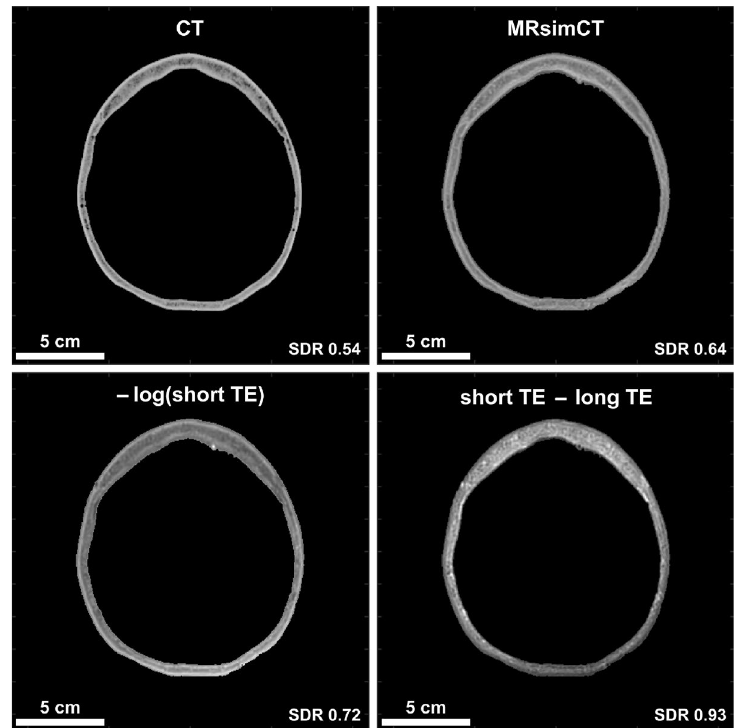
Figure 1. CT contrast of the skull compared to various MR contrasts (skull A). Cortical and trabecular bone contrast is clearly depicted by CT and may be preserved by two of the three MR post-processing methods. The units for MRsimCT, –log(short TE), and short TE–long TE are not the same, thus different windowing and leveling were used. Scale bars and skull density ratios (SDRs) are shown at the bottom of each image. MRsimCT was the preferred choice based on bone contrast, minimal SDR change compared to CT, minimal background signal bias, and generalizable post-processing. Therefore, it was used for the remainder of this study.